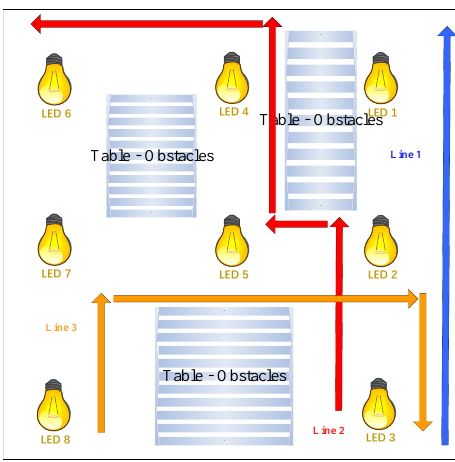
Figure 11 LED light source distribution in site 1